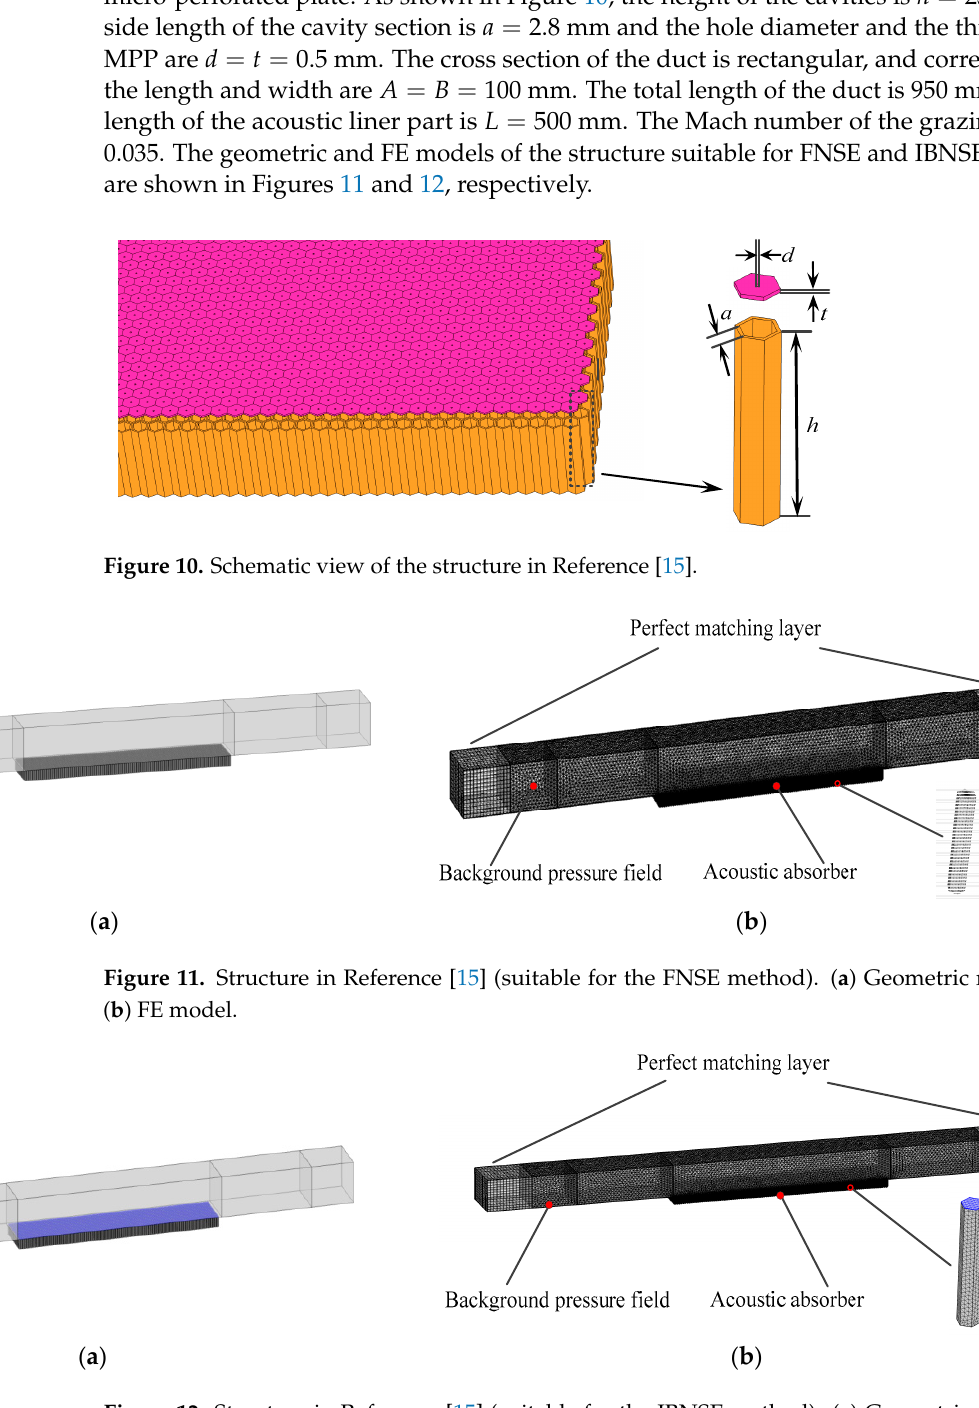
( b ) Figure 13. Comparisons of transmission loss and absorption coefficient of the structure in Reference [15]. ( a ) Transmission loss and ( b ) acoustic absorption coefficient. Tables 2 and 3 show the errors of the predicted transmission loss and absorption co- efficient obtained by the IBNSE method and the FNSE method compared to the experi- mental results given by Reference [15]. As demonstrated in Tables 2 and 3, the IBNSE method proposed in this paper had satisfactory computational accuracy. Table 2. Transmission loss errors corresponding to the FNSE and the IBNSE methods. Methods